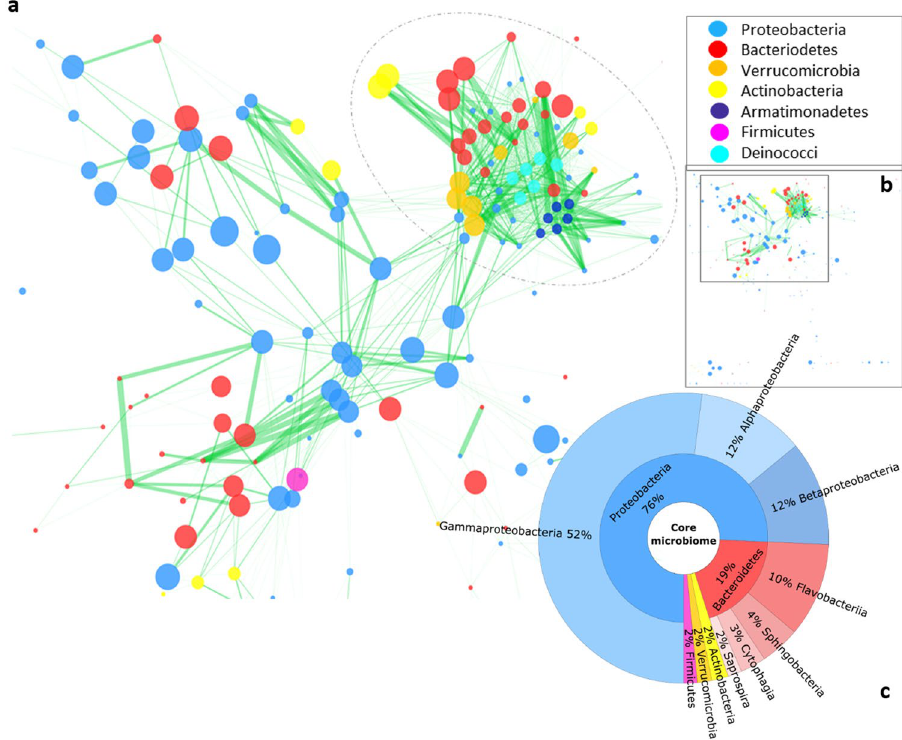
Figure 3. Significant co-occurrence relationships among the Brassica vegetable microbiomes. Only significant interactions are shown (p < 0.0004; q < 0.0004). Nodes correspond to OTUs and the size of the nodes corresponds to the relative abundance of the OTUs in the dataset. Green edges represent significant positive Spearman’s correlation between the pairs of OTUs. The edge width indicates the significance of interaction. The color of the nodes indicates the corresponding phylum of the OTUs as described in the legend on the right. Circle was drawn to highlight the denser part of the network. The Figure in ( b ) shows the full network highlighting the part of the network zoomed in ( a ). ( c ) Core microbiome shared by all Brassica samples representing the taxonomic classification up to class level in ascending order using a threshold of 1% abundance.